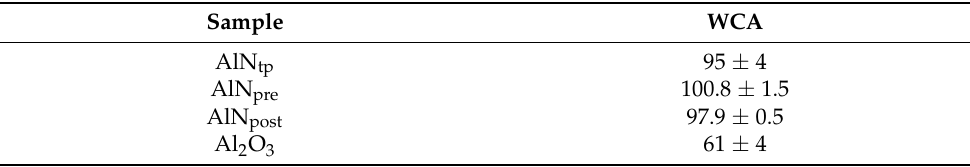
Table 2. Water contact angle (WCA) of thin aluminum compound